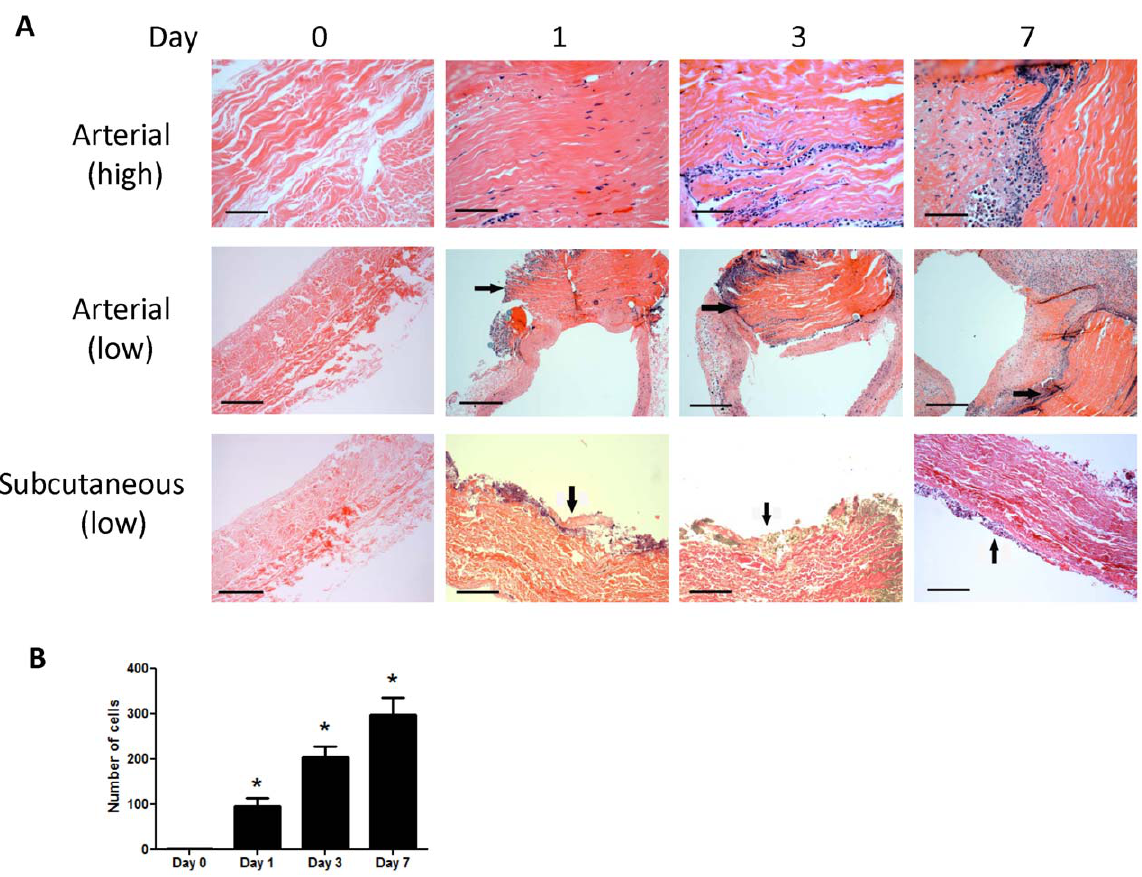
Figure 2. Increasing numbers of infiltrating cells into the arterial patch. A ) Photomicrographs of bovine pericardial patches, implanted into either an arterial or subcutaneous position, and shown at either high or low magnification. Scale bar, 40 microns. B ) Graph of cell count in the patch over time; mean of 4 high power fields per patch; n=2. *, p , 0.0001.